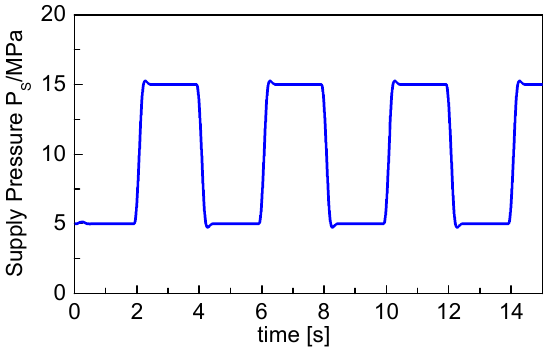
Figure 13. Oil supply pressure as a function of time.